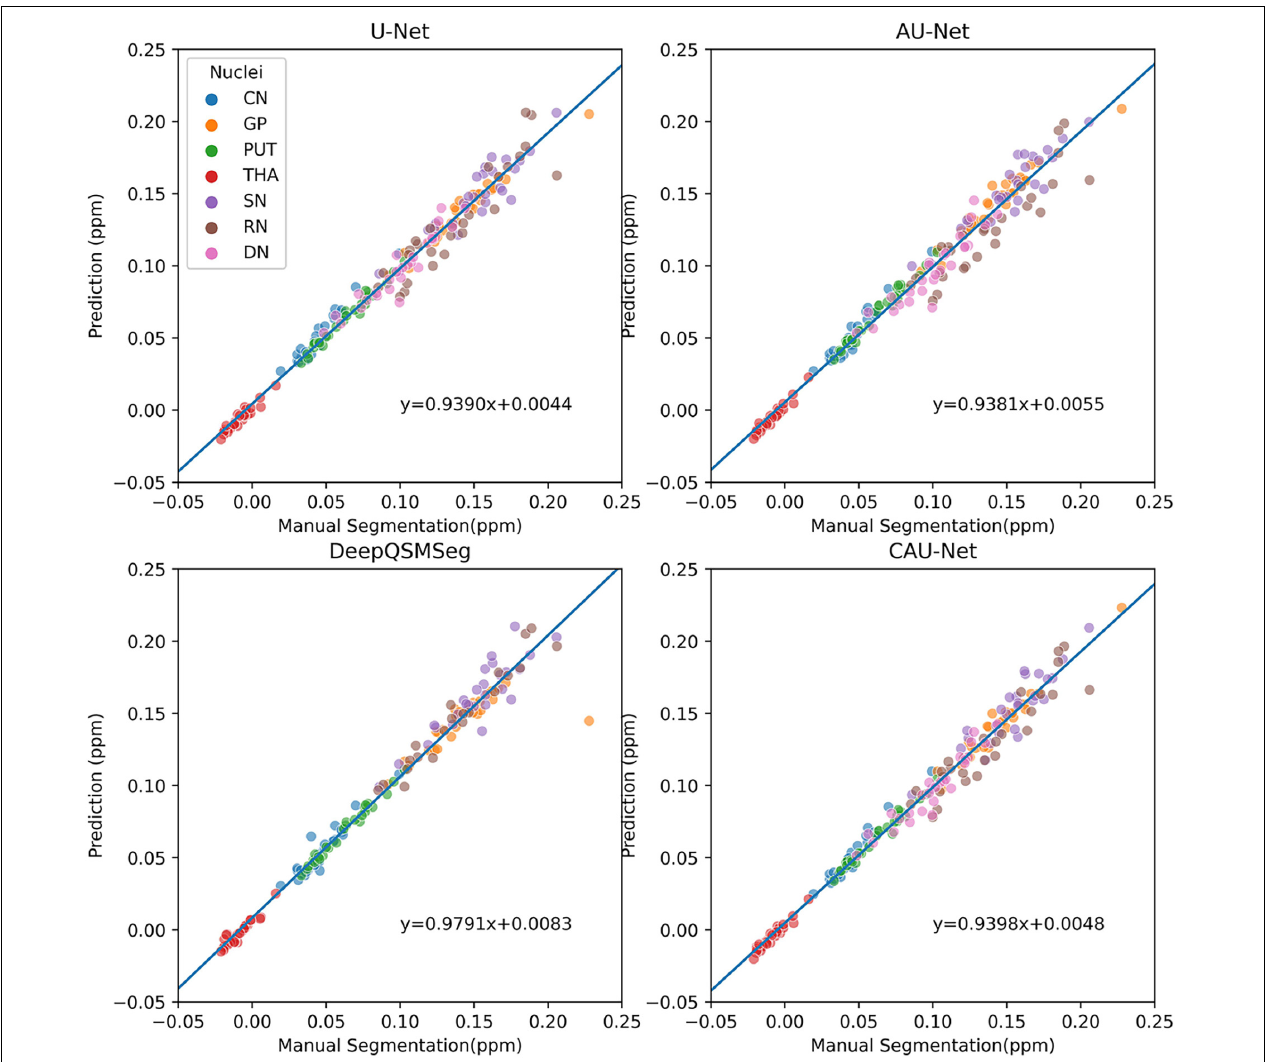
FIGURE 7 | Scatter plot of susceptibility values measured from manual segmentations and automatic segmentations on the subjects of the test set of Dataset I. The correlation lines are also plotted. For DeepQSMSeg, we omitted the results on DN.